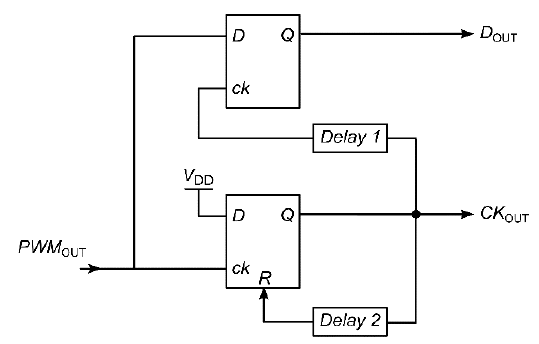
Figure 17. Simplified schematic of the RX base-band PWM demodulator.